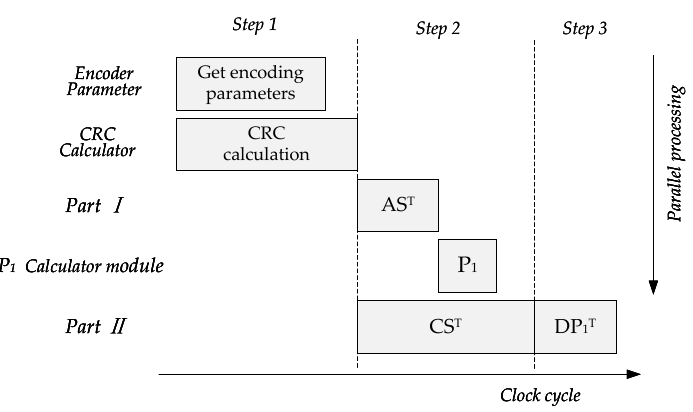
Figure 6. Parallel operation process of encoder.